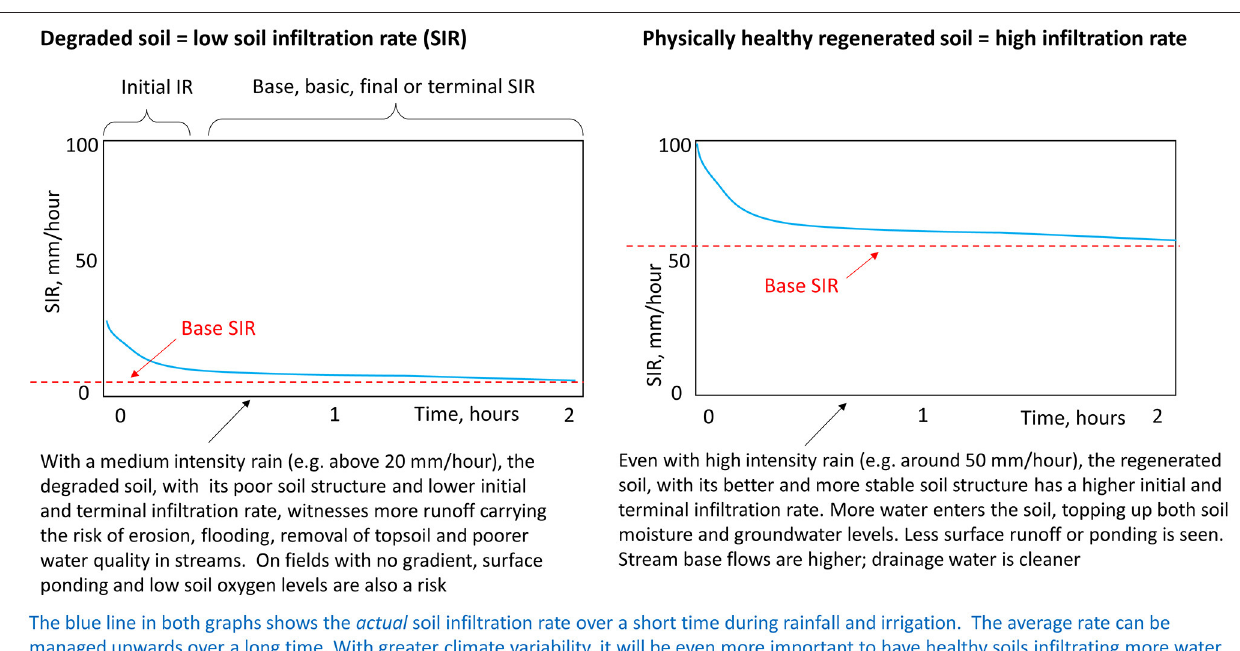
FIGURE 3 | Soil infiltration rate (SIR) changing over time in two soil